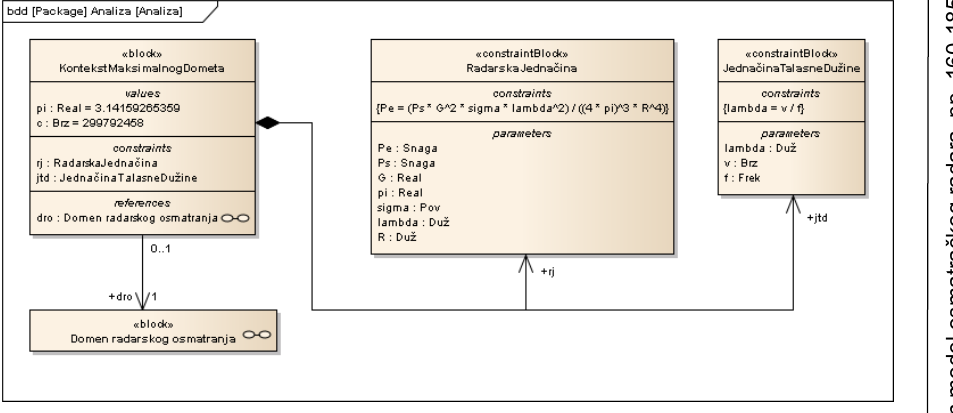
Figure 9 – Maximal range analysis